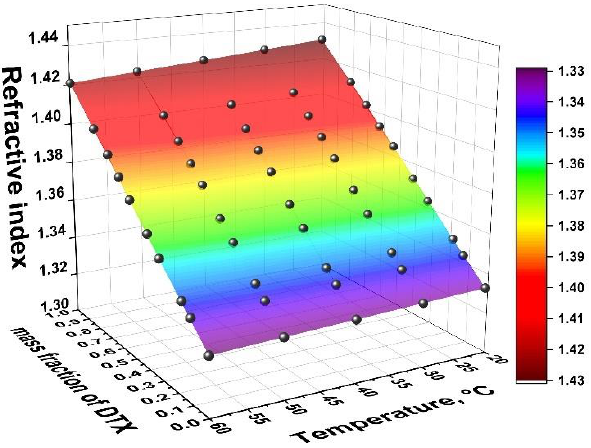
Figure 4. Experimental refractive indices n D versus temperature and mass fraction of DTX.